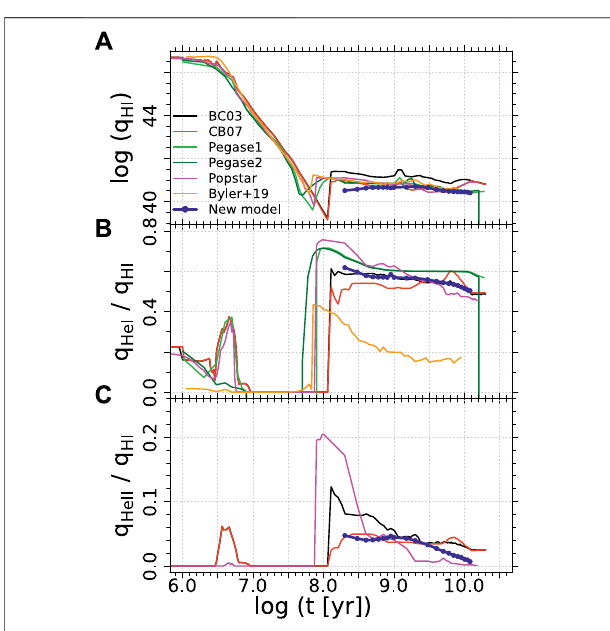
FIGURE 4 | Evolution of the H I ionizing photon rates in units of s − 1 M − 1 ⊙ (A) , the ratio between the He I and H I ionizing photon rates (B) , and between the He II and H I ionizing photon rates (C) . We show the predictions from solar-metallicity models by Bruzual and Charlot (2003, B03, black lines ); an updated version of BC03 (CB07, red ); two sets of models by Fioc and Rocca-Volmerange (1997, Pegase1 and Pegase2 in light and dark green , respectively); models by Mollá et al. (2009, Popstar, magenta ); and a more recent model by Byler et al. (2019, Byler+19, orange ). Our stellar population models computed with the new post-AGB evolutionary sequences by Miller Bertolami (2016) are shown in